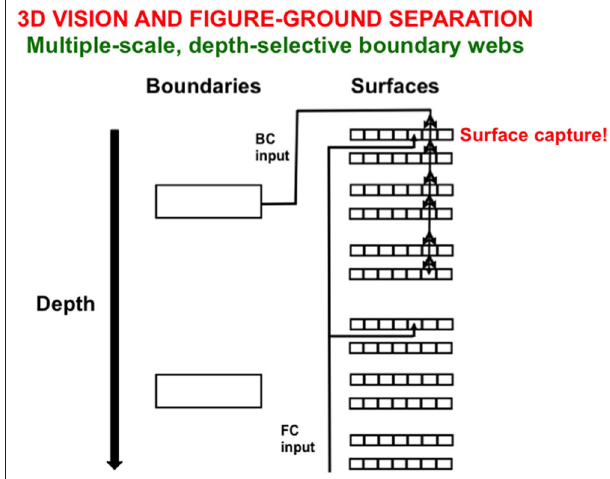
FIGURE 10 | Spatially abutting and collinear boundary contour (BC) and feature contour (FC) signals in a Filling-In-DOmain, or FIDO, can trigger depth-selective filling-in of the color carried by the FC signal in that FIDO. See the text for details [adapted with permission from Grossberg and Zajac